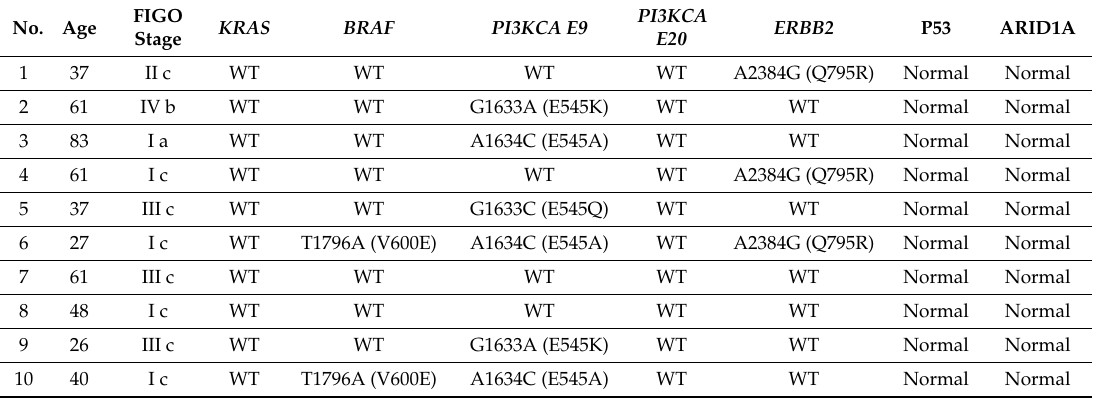
Table 1. Mutation and imunohistochemical analysis of low grade serous ovarian carcinoma (LGSC). WT; Wild